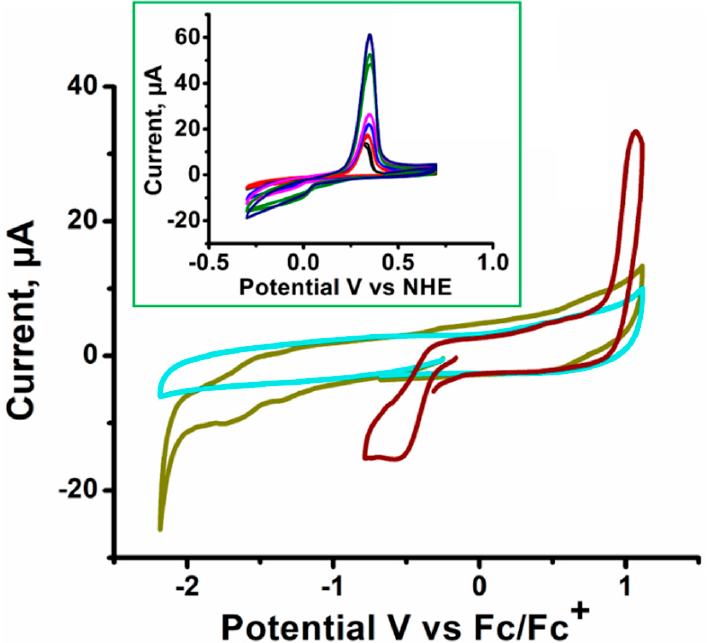
Figure 4. Cyclic voltammograms of 1 mM blank (turquoise), ligand (green) and complex 3 (brown) in 0.1 M [NBu 4 ][PF 6 ]/CH 3 CN. Scan rate at 100 mV/s. (Inset) Cyclic voltammograms complex 3 in 0.1 M HClO 4 at varying scan rate for complex 3 in 0.1 M HClO 4 . Scan rates (mV/s): 10 (black), 20 (red), 50 (blue), 75 (pink), 100 (green), 150 (purple).